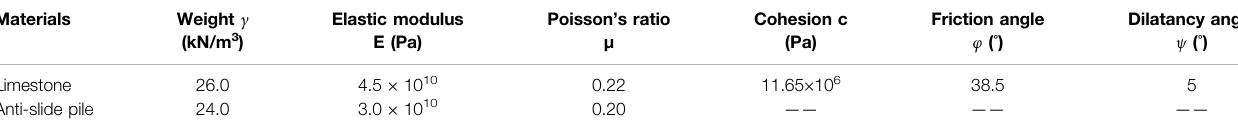
TABLE 2 | Physical and mechanical parameters of the anti-slide pile and the considered limestone.